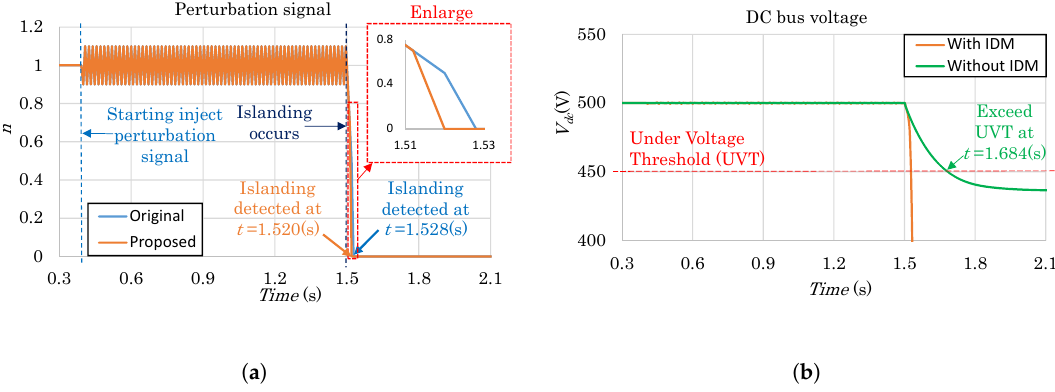
Figure 18. Result in case of multi-PV operation, 40 kW PV, another islanding condition (case 6): ( a ) Perturbation signal and ( b ) DC bus voltage (with and without